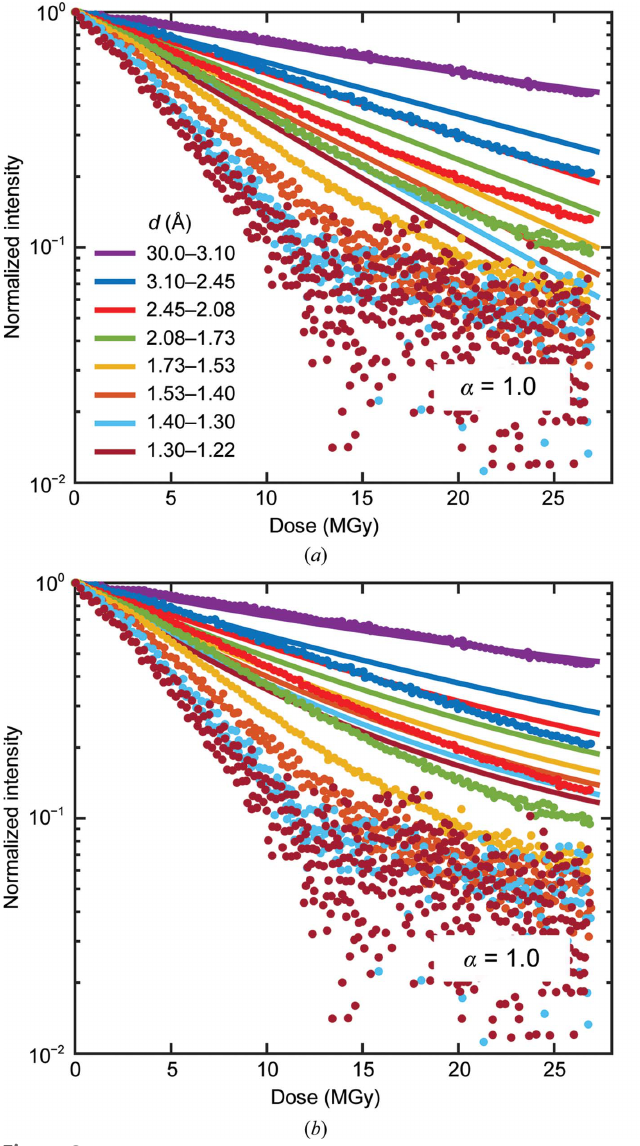
Figure 2 Experimental data (solid circles) for integrated intensity in resolution shells versus dose for thaumatin crystals at 100 K, as measured by Liebschner et al. (2015). Absolute intensities in each resolution shell (Fig. 4 in the original manuscript) have been normalized by the first (approximately zero-dose) intensity point; non-normalized data are shown in Supplementary Fig. S4. The solid lines indicate results from simulations assuming ( a ) a perfect top-hat incident X-ray beam profile and an exponent (cid:2) = 1 in (4), ( b ) the measured beam profile (Fig. 1 in the original manuscript, reproduced as Supplementary Fig. S3) and (cid:2) = 1, and ( c ) the measured beam profile and a best-fit exponent (cid:2) =